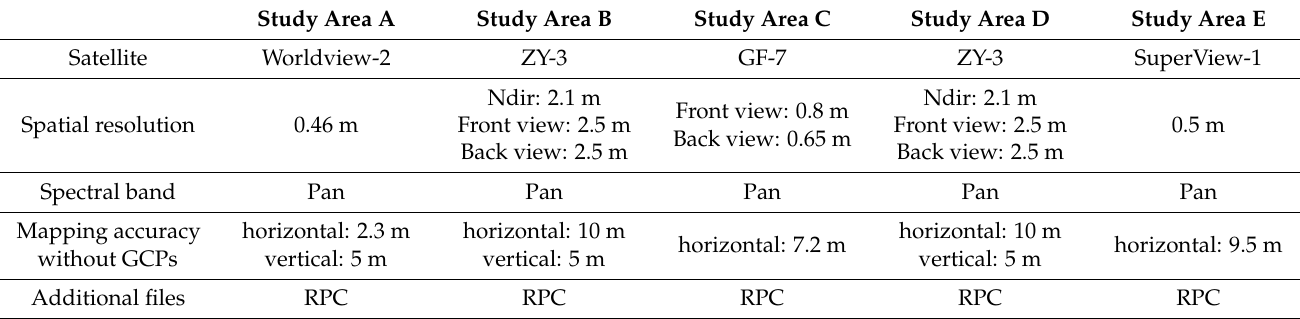
Table 1. The main parameters of the image in the study